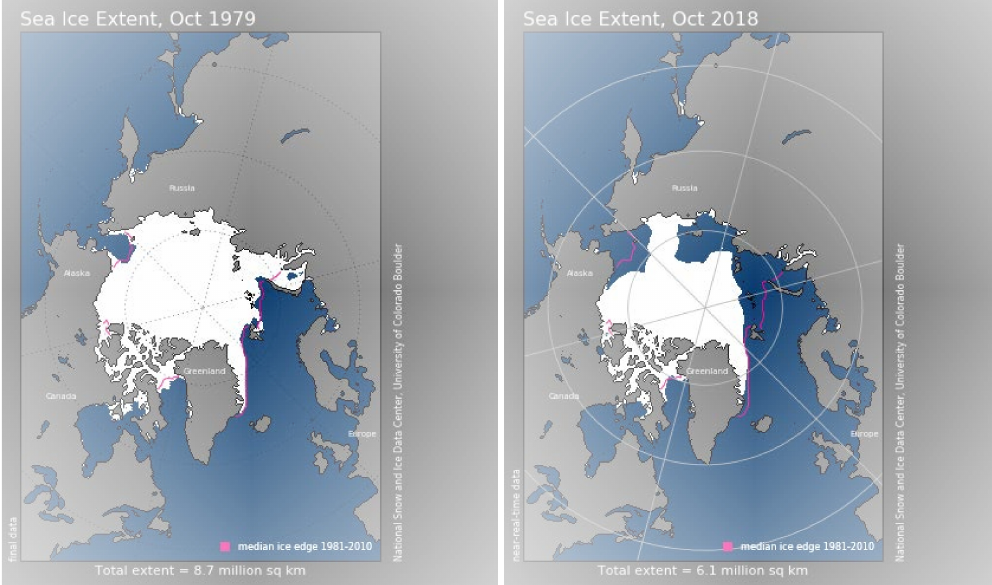
Figure 2. Sea ice extent in October 1979 ( left ) and October 2018 ( right ).